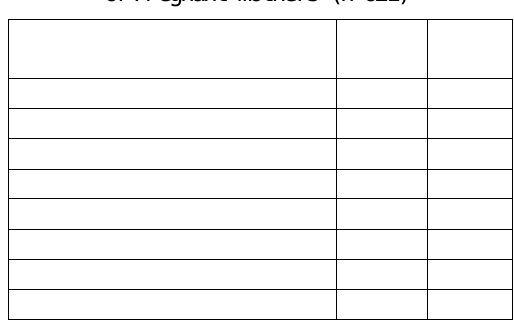
Indications for ultrasonographic examination of Pregnant mothers